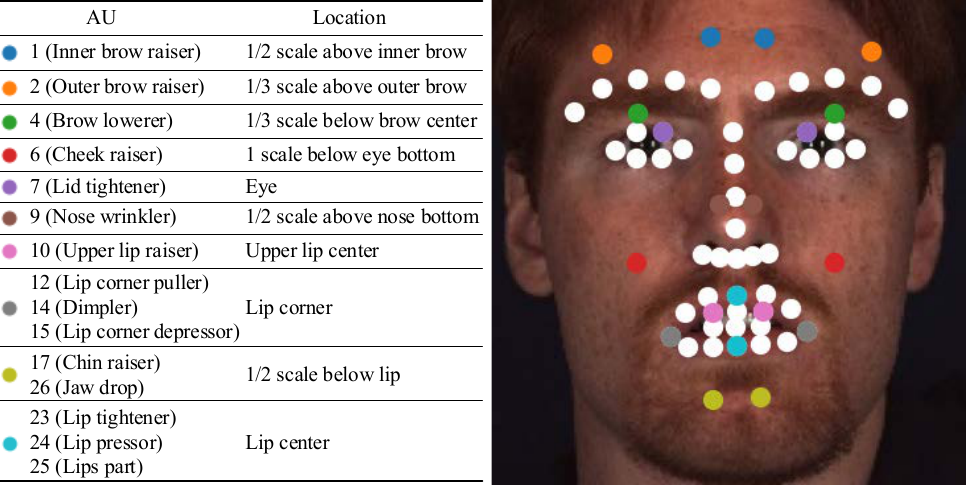
Figure 3. Definition of the central locations of 15 popular AUs for a normalized face with eye centers on the same horizontal level [2,3], in which “scale” denotes the distance between two inner eye corners. Each AU has two symmetric centers specified by two correlated facial landmarks, in which landmarks are in white and AU centers are in other